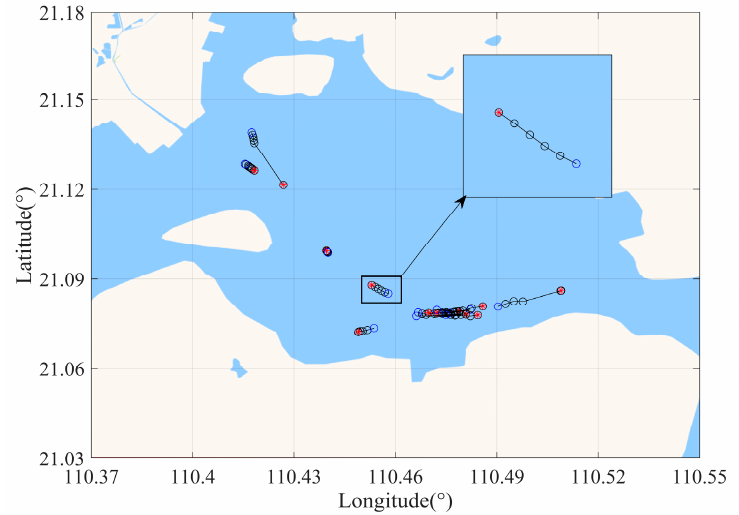
Figure 21. Example of trajectories less than 10